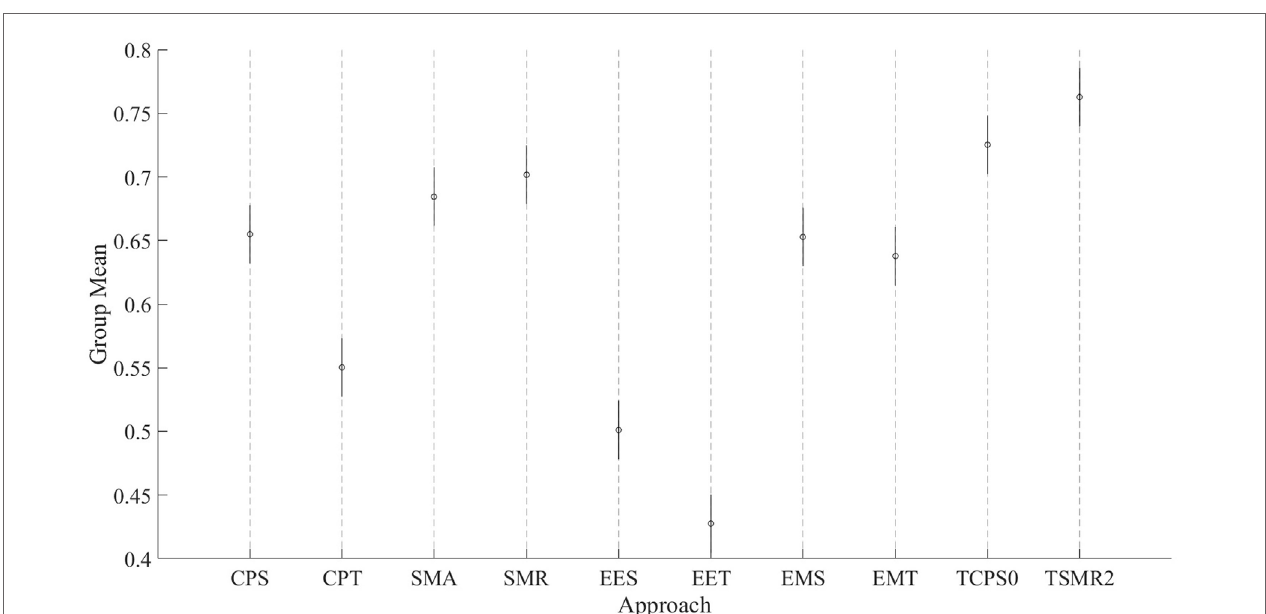
FigUre 4 | comparison of the eight initial approaches plus the two best optimization results . Each line represents the 95% confident interval for each of them. The circle in the middle corresponds to the mean for that group. Overlapping intervals between two approaches means that they were not significantly different.